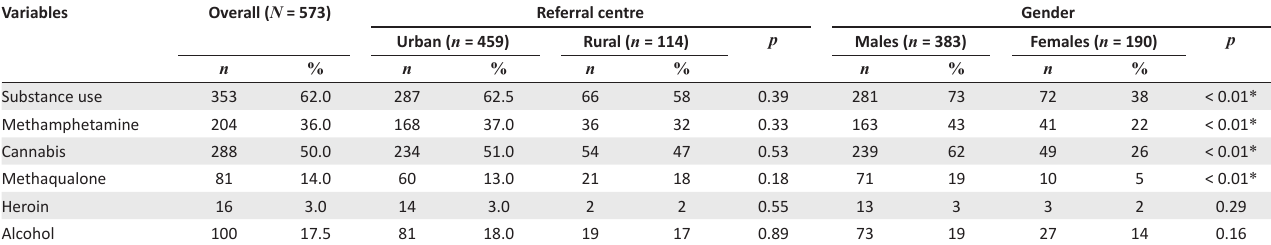
TABLE 5: Relationship between specific substances, referral centre and gender.